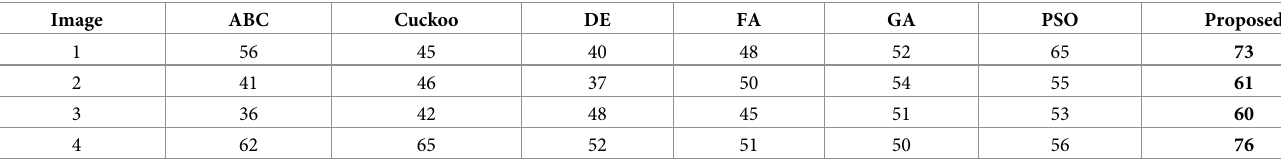
Table 10. Comparison of various contrast enhancement techniques using MOS.